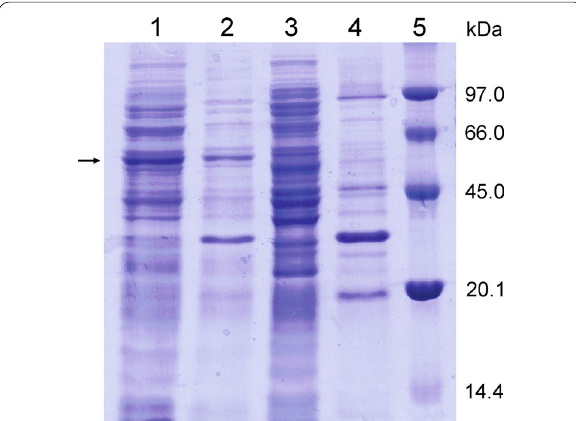
Fig. 2 SDS-PAGE of recombinant BVMO Lepto . Samples correspond- ing to the soluble ( lane 1 ) and insoluble ( lane 2 ) fractions of protein extracts of E. coli BL21(DE3)/pHLb01 and the soluble ( lane 3 ) and insoluble ( lane 4 ) fractions of BL21(DE3) protein extract were sub- jected to 12% SDS-PAGE followed by Coomassie Blue staining. Lane 5 molecular marker. The arrow indicates the protein band correspond- ing to the recombinant BVMO Lepto Fig. 3 General Baeyer–Villiger oxidation catalyzed by